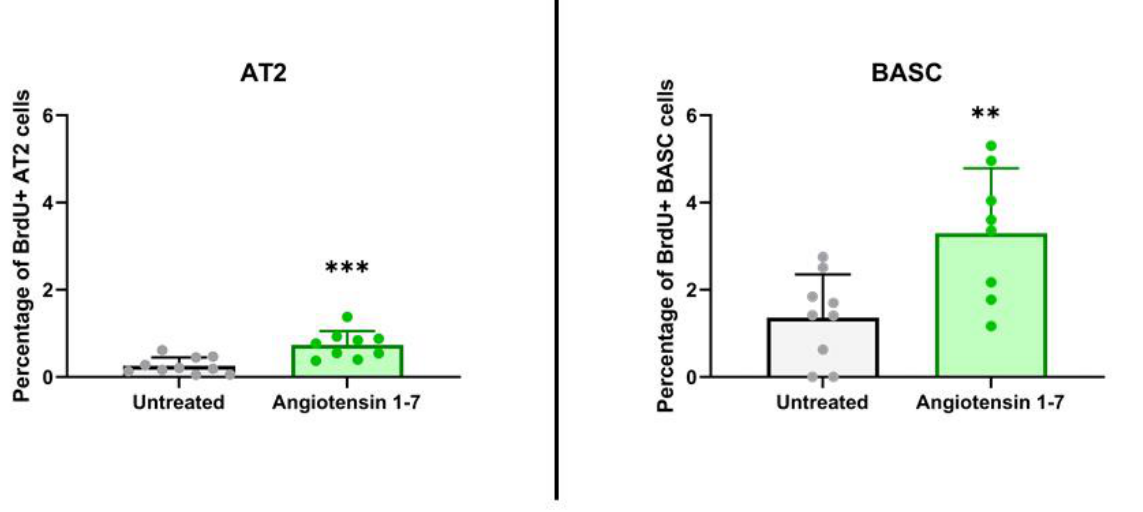
Figure 4. Murine alveolar type 2 cells and bronchoalveolar stem cells proliferate in vivo after stimulation by angiotensin 1 – 7. The graphs present incorporation of BrdU into AT2 cells and BASCs in response to 11-day administration of Angiotensin 1 – 7 in vivo. The percentage of AT2 cells or BASCs that showed proliferative activity (BrdU positive) were normalized to total number of the cells of these cell population. ** p < 0.01, *** p < 0.001 compared with control — not stimulated group.